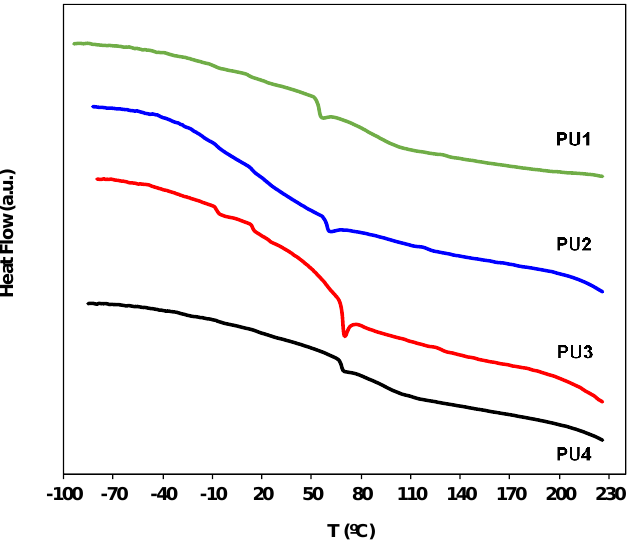
Figure 10. The DSC thermograms of the polyurethanes samples PU1 – PU4 (exo up).